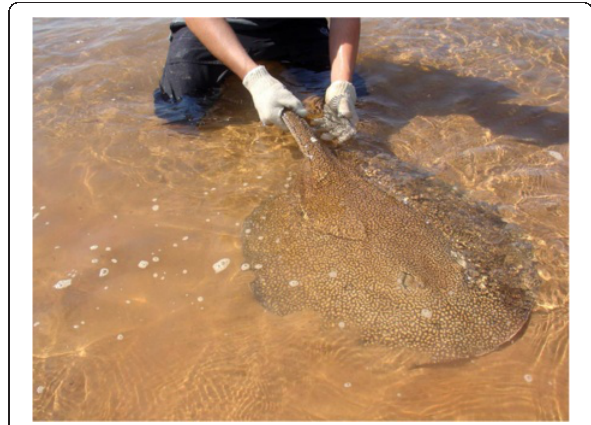
Figure 6 Potamotrygon falkneri , a species common in Paraná River, in Southeastern and Southern Brazil, Uruguay, Paraguay and Argentina. Photo by: Vidal Haddad